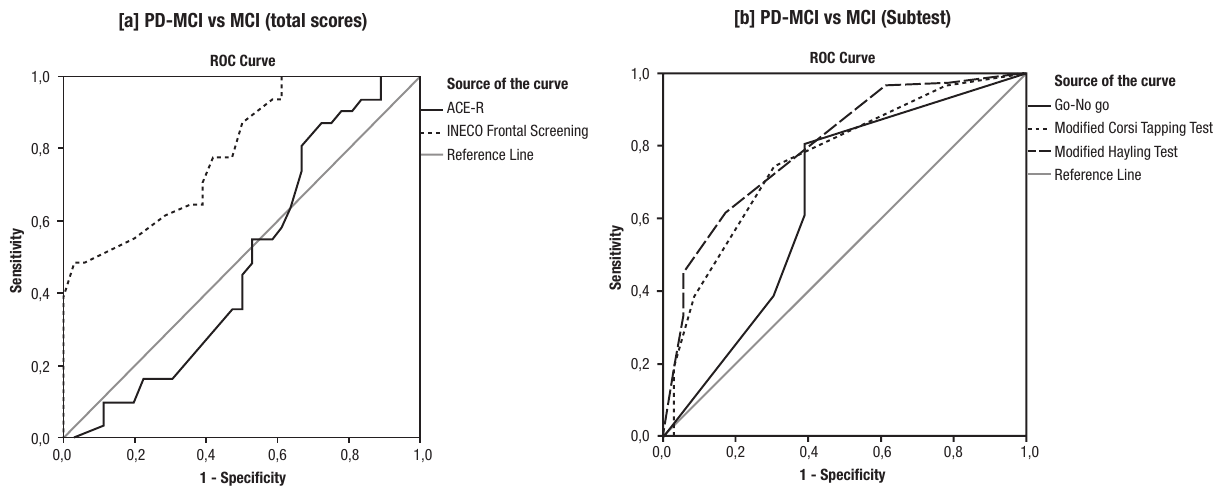
Figure 2. ROC curves show [a] ACE-R (total score) and INECO Frontal Screening (total score) for distinguishing between PD-MCI/MCI and [b] INECO Frontal Screening (sub-scores) for distinguishing between